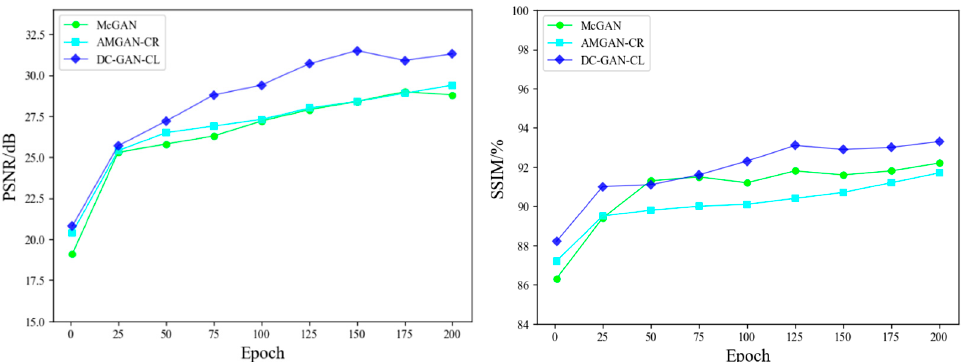
Figure 9. Trends in the PSNR and SSIM values of McGAN, AMGAN-CR, and DC-GAN-CL on the RICE2 test set throughout training.